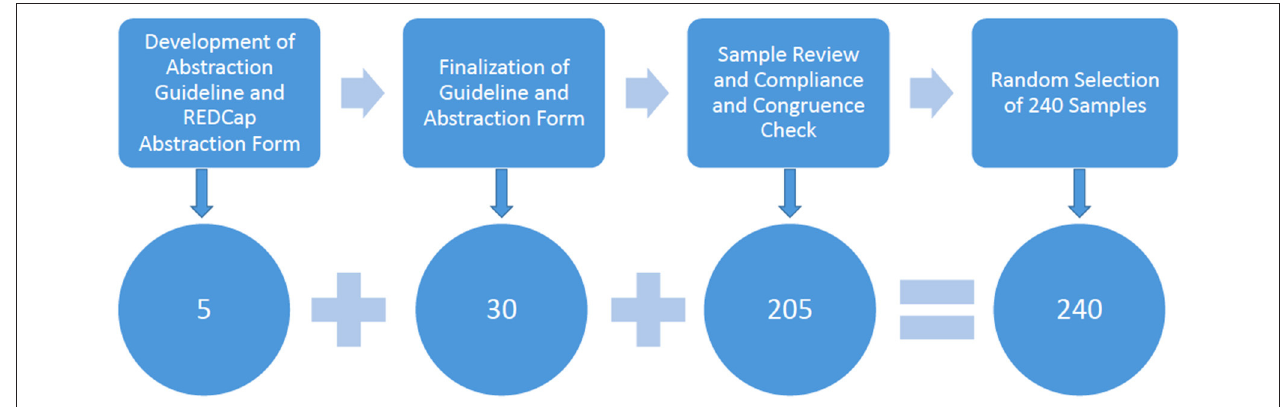
FIGURE 1 | Flow diagram demonstrating the different steps during the medical consult review process (single column fitting image).